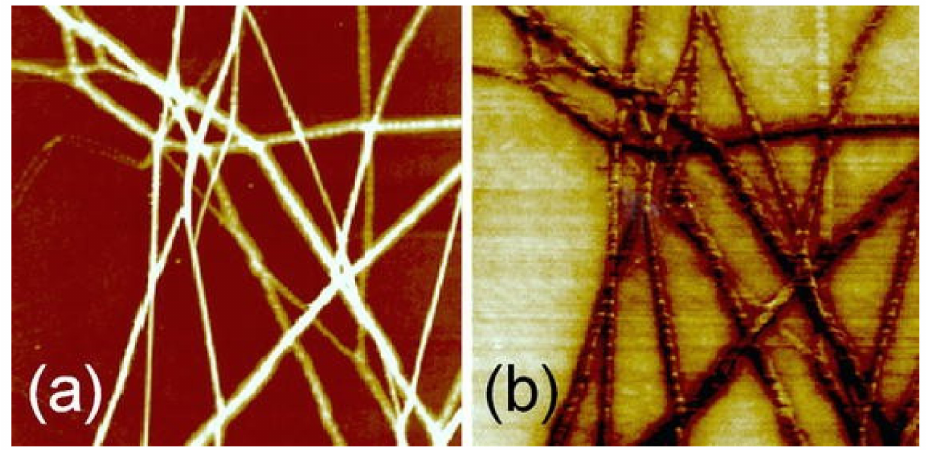
Figure 8. ( a ) AFM and ( b ) MFM images of Fe doped ZnO nanofibers. The scanned areas of both images are 30 µ m × 30 µ m. Reprinted from [80] and originally published under a CC-BY-NC